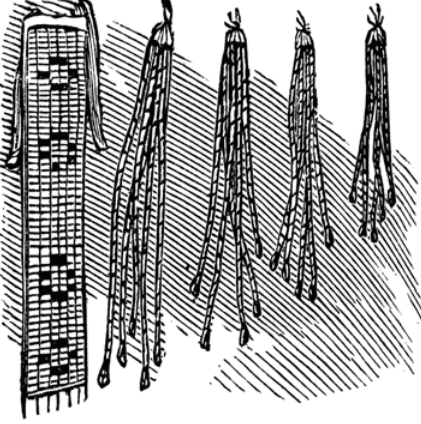
Fig. 1. Native American